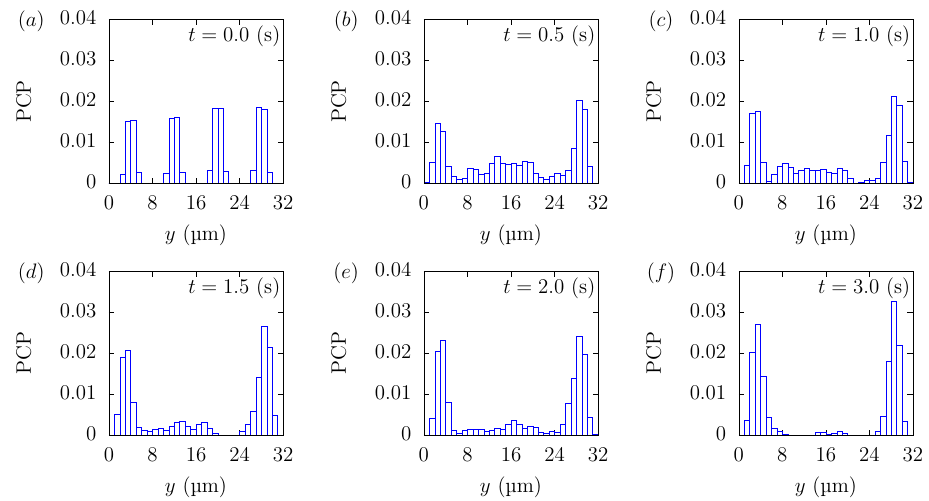
Figure 4. Particle Concentration Profiles (PCPs) in a straight channel of 224 × 32 × 32 µ m for ˙ γ w = 972 s − 1 , Ht = 20% at ( a ) t = 0, ( b ) t = 0.5, ( c ) t = 1.0, ( d ) t = 1.5, ( e ) t = 2.0, and ( f ) 3.0 s. Each graph corresponds to the results in Figure 3.